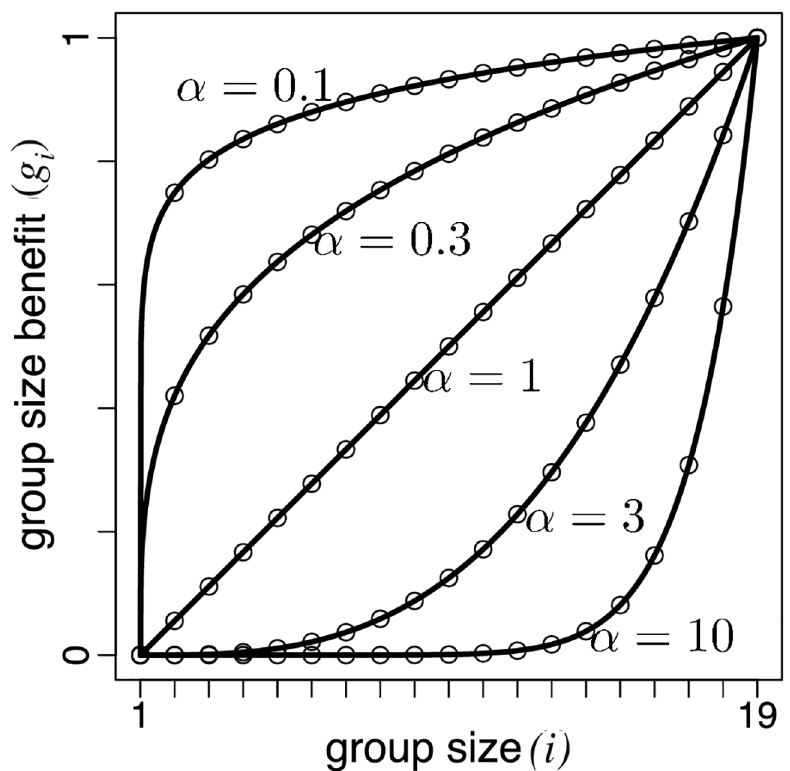
Fig 5. Advantages of group living. Group size benefit g i = [( i − 1)/( n − 2)] α as a function of group size for different values of the degreeof complementarity α . If α < 1, g i is concave; if α = 1, g i is linear; if α > 1, g i is